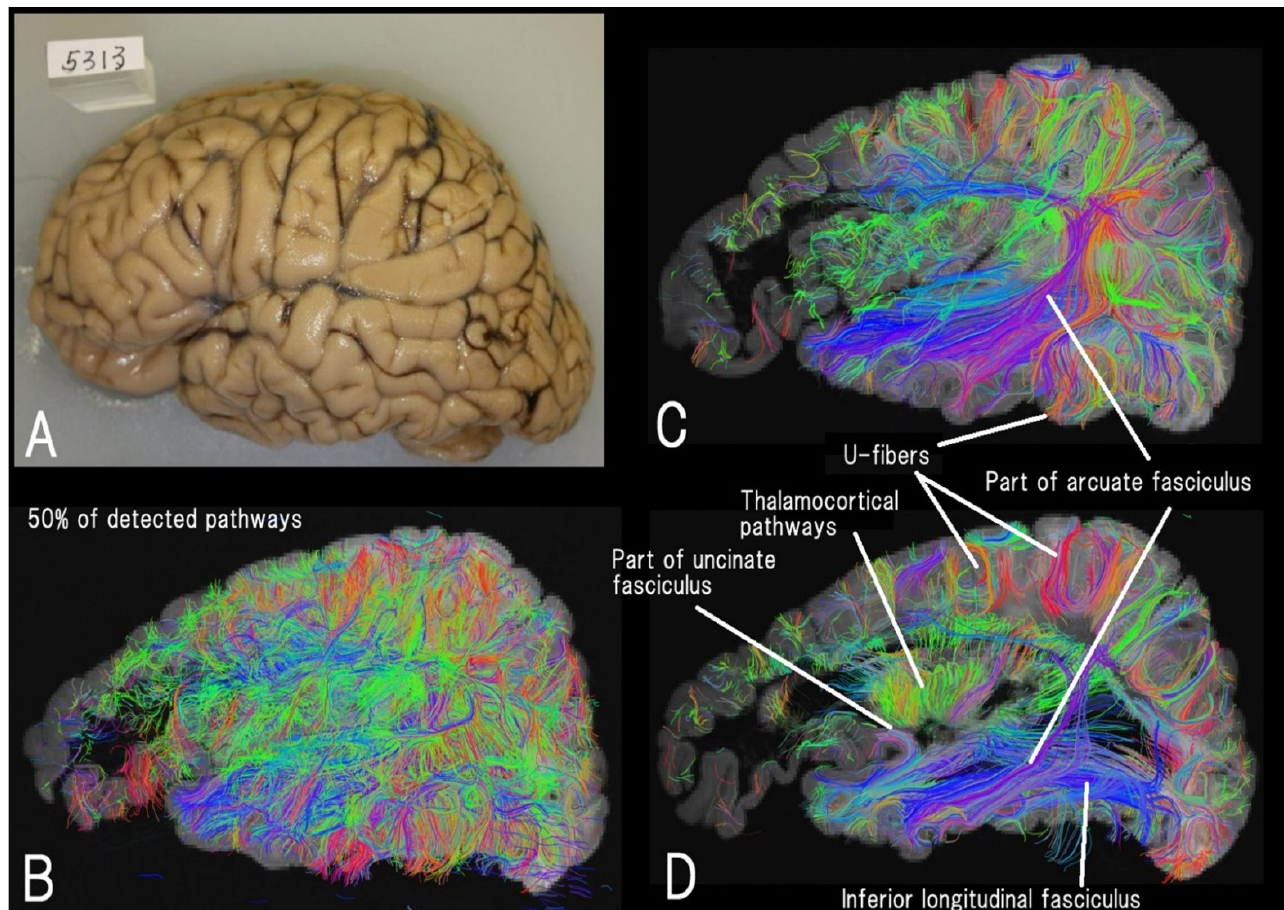
Figure 2. High-angular resolution diffusion MRI (HARDI) tractography of a left hemisphere ( A ) of a seven-year-old male with Alexander disease ( B – D ). Different levels of sagittal views of 50% of detected fiber pathways are shown. Thalamocortical, inferior longitudinal fasciculus, a part of the arcuate fasciculus and uncinate fasciculus, and many short-range cortico-cortical (u-fiber) pathways are clearly imaged (reproduced with permission to reuse [130]).